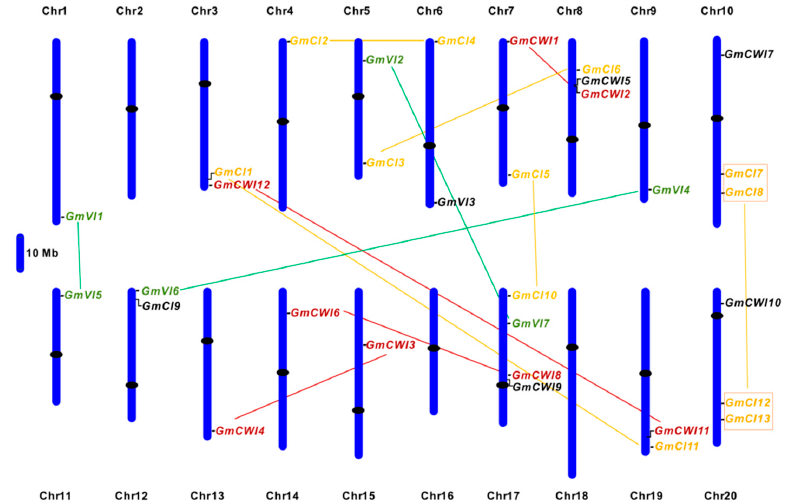
Figure 2. Invertase gene distributions in soybean chromosomes. Chromosomal distributions of invertase gene candidates are clustered on the basis of their physical locations on chromosome. Pairs of gene speculated to have undergone segmental duplication are positioned in same color and linked each other by a straight line. The centromeres are colored by black ovals.